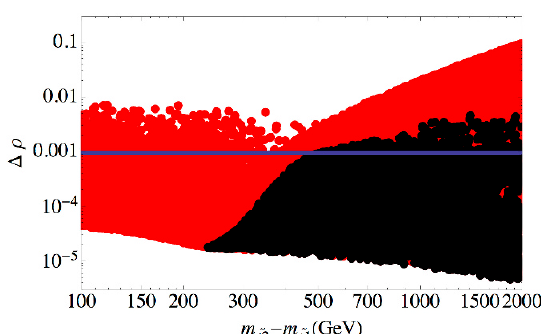
Figure 2 . (cid:1) (cid:26) for all scanned points (red) and those compatible with 120 < m h < 130 GeV (black), as a function of the mass splitting between the two stop mass eigenstates. All points have m ~ and we have scanned over all possible values of the mixing angle, 0 (cid:20) s 2 line denotes (cid:1) (cid:26) = 9 : 6 (cid:2) 10 (cid:0) 4 , the 2 (cid:27) upper limit from